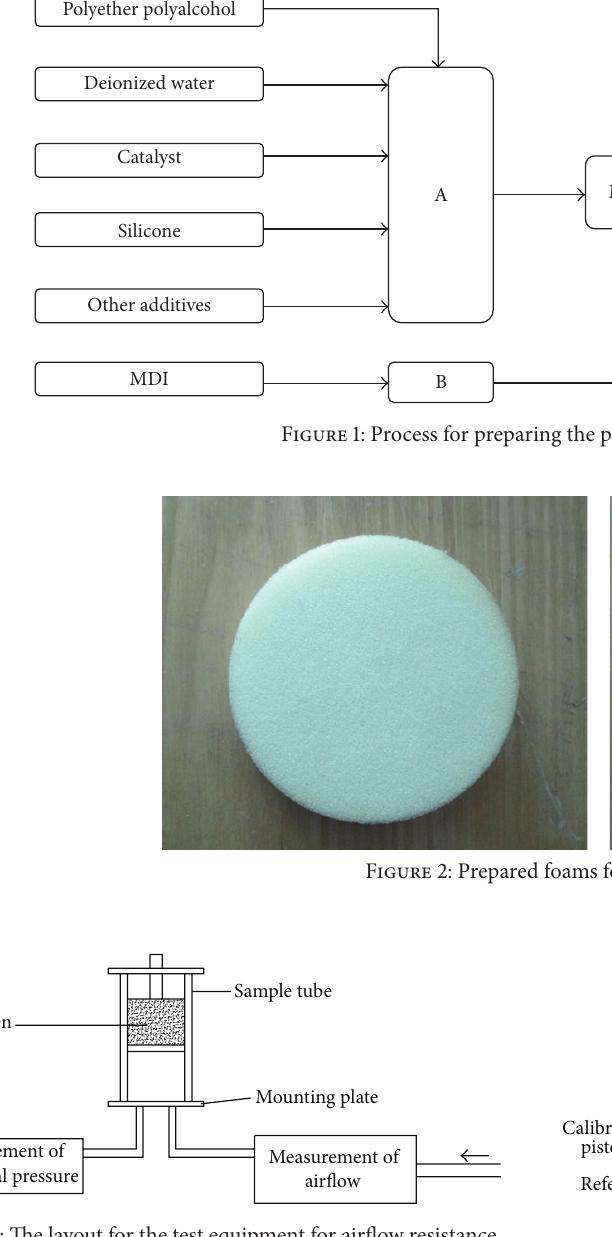
Figure 3: The layout for the test equipment for airflow resistance.